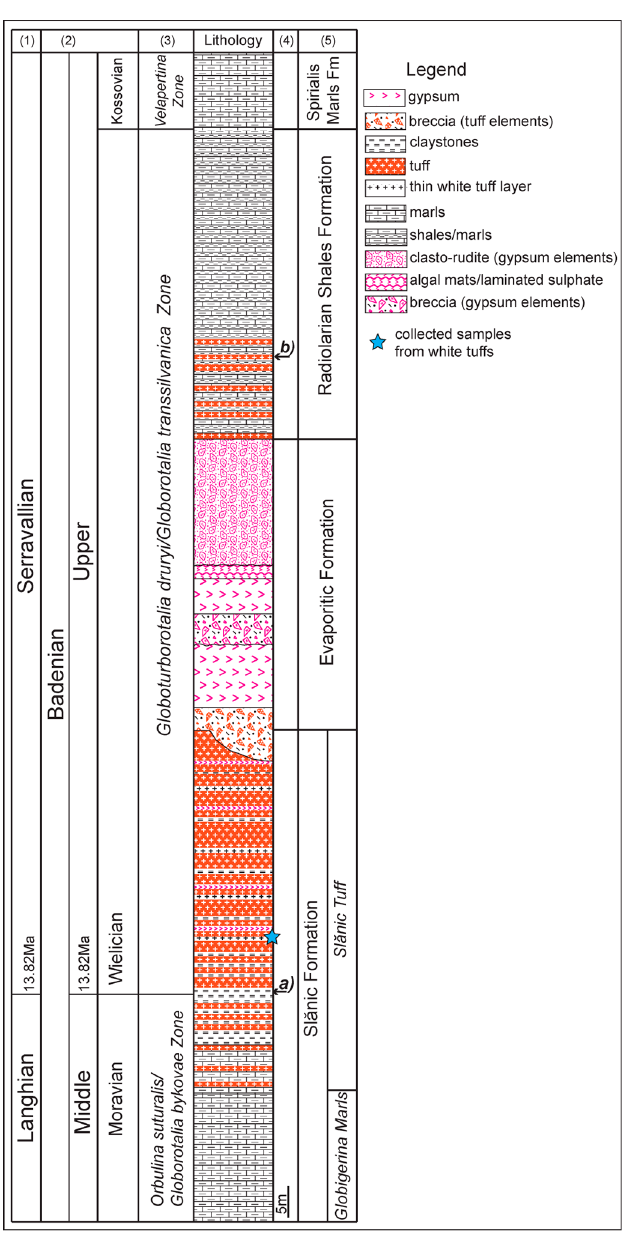
Figure 2. Lithostratigraphy at the Green Stone Hill (Muntele Piatra Verde) after [25,29] and own mapping. Position of the white tuff layer with biotite is shown. ( 1 ) Mediterranean regional stages [30]; ( 2 ) Central Paratethys regional stages [31]; ( 3 ) Forams biozonation after [17,27,28,32]; ( 4 ) Events: ( a ) FO Globoturborotalia druryi and FO Goborotalia transsylvanica [17,27,28,32]; ( b ) absolute age of a tuff layer (13.45 ± 0.06 Ma) after [33]; ( 5 ) Formation names for the post-tectonic cover deposits of the Tarc ă u nappe.